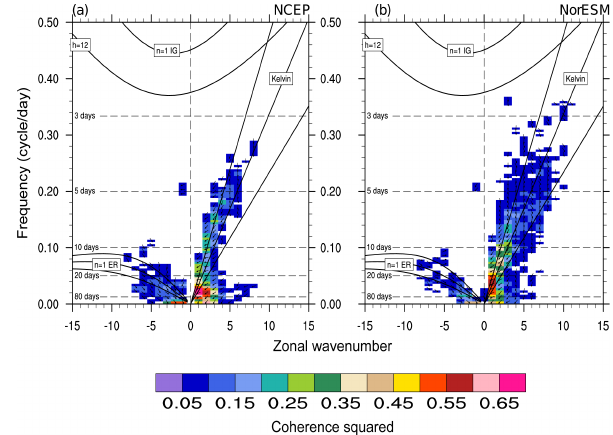
Fig. 20. Coherence squared (colors) and phase lag (vectors) between zonal winds at 850hPa and OLR are shown for (a) NCEP winds and NOAA satellite OLR, and (b) NorESM. Only the symmetric spectra are shown here. Cross spectra are calculated using daily data during all seasons on 256 day-long segments, overlapping by 206 days. Vectors represent the phase by which wind anomalies lag OLR anomalies, increasing in the clockwise direction. A phase of 0 ◦ is represented by a vector directed upward. Dispersion curves for the ( n = − 1) Kelvin, n =1 equatorial Rossby (ER) and n =0 eastward inertia-gravity (EIG) waves corresponding to three equivalent depths ( h =12, 25 and 50m) in the shallow water equations are overlaid (black contours). MJO is defined as the spectral components within zonal wave numbers 1–3 and having periods of 20–80days. Fig. 19. November–April wavenumber-frequency spectra of 10 ◦ S–10 ◦ N averaged daily zonal 850 hPa winds of (a) NCEP (1979–2008) and (b) NorESM (1976–2005), and daily OLR fields of (c) NOAA satellite OLR (1979–2008) and (d) NorESM (1976–2005). Individual spectra were calculated for each year and then averaged over all years of data. Only the climatological seasonal cycle and time mean for each November–April segment were removed before calculation of the spectra. Units for the zonal wind (OLR) are m − 2 s − 2 (Wm 2 s − 1 ) per frequency interval per wavenumber interval. The bandwidth is (180 day − 1 ).